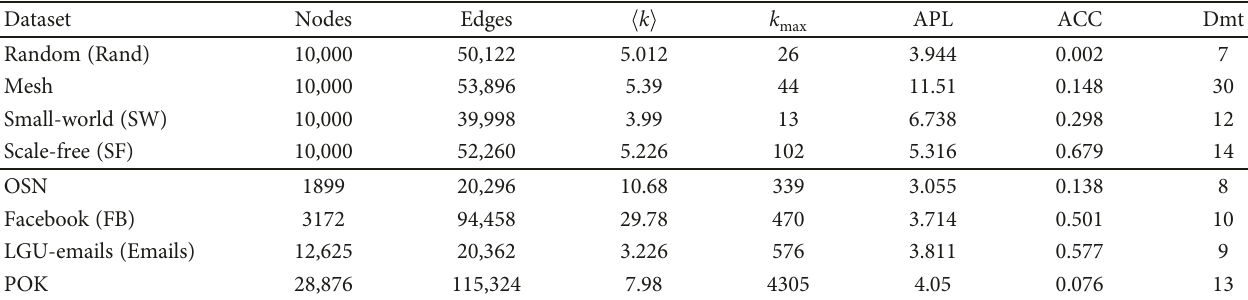
Table 1: Graph statistics of the eight datasets detailing the number of nodes, edges, average degree ( k ), maximum degree ( k path length ( APL ), average clustering coe ffi cient ( ACC ), and network diameter ( Dmt